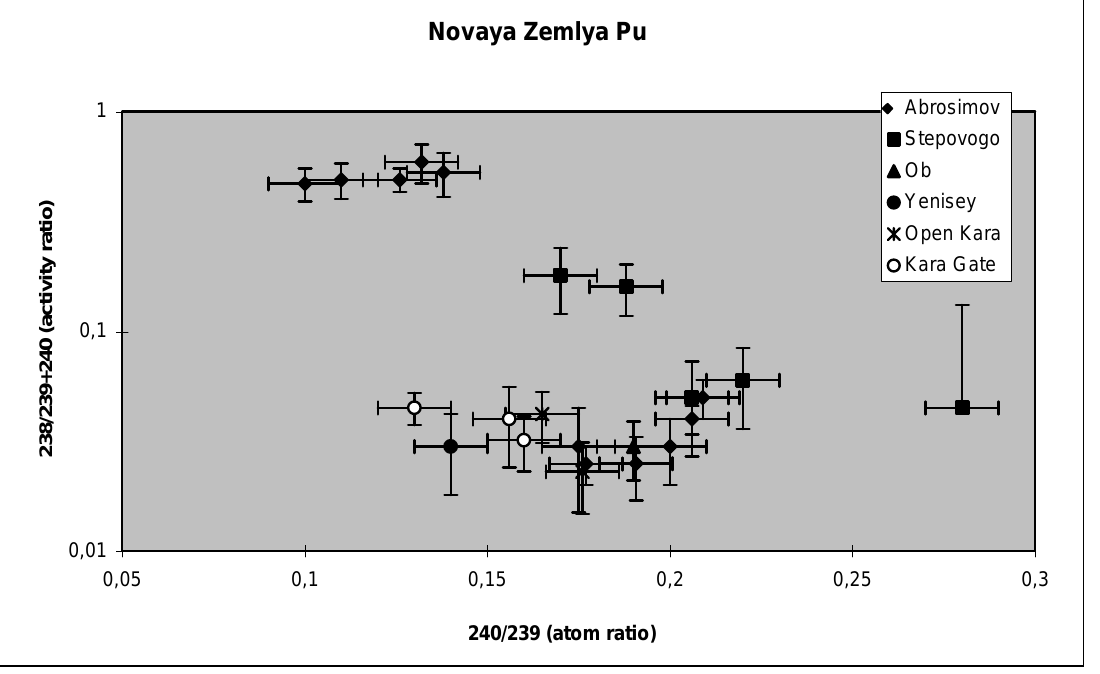
FIGURE 10 . Two-dimensional plot of 240 Pu/ 239 Pu atom ratios and 238 Pu/ 239+240 Pu activity ratios in samples from the Kara Sea and Novaya Zemlya.